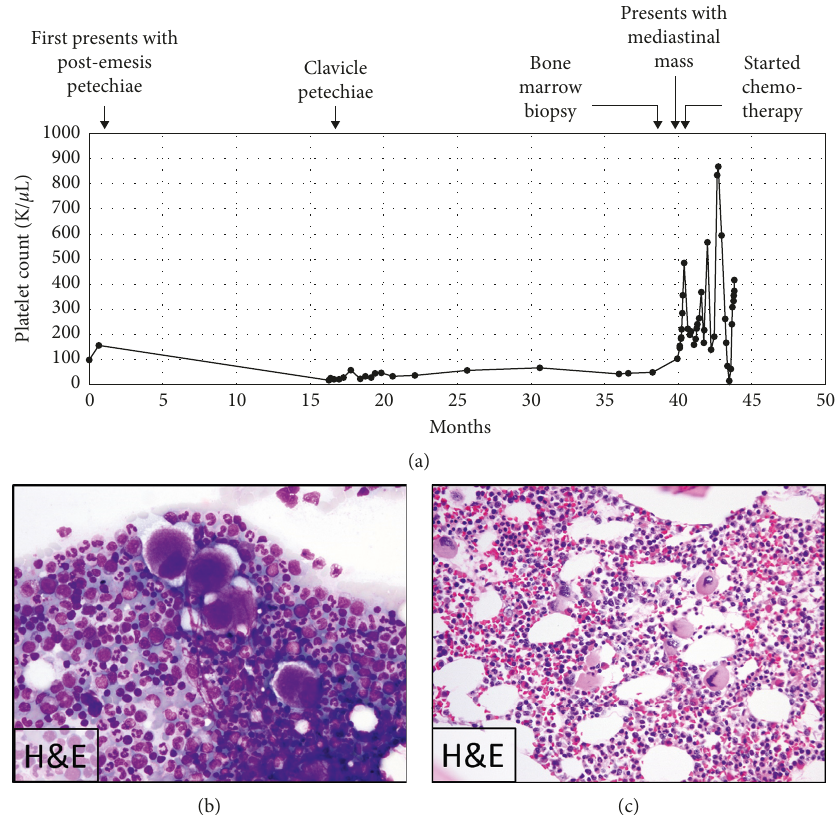
Figure 1: Trend of platelet count over time. (a) The patient’s first platelet count was taken 37.1 months prior to the first point on the curve and was within normal limits at 292,000/ μ L. (B-C) Bone marrow aspirate (b) and biopsy (c) demonstrating increased numbers of morphologically normal